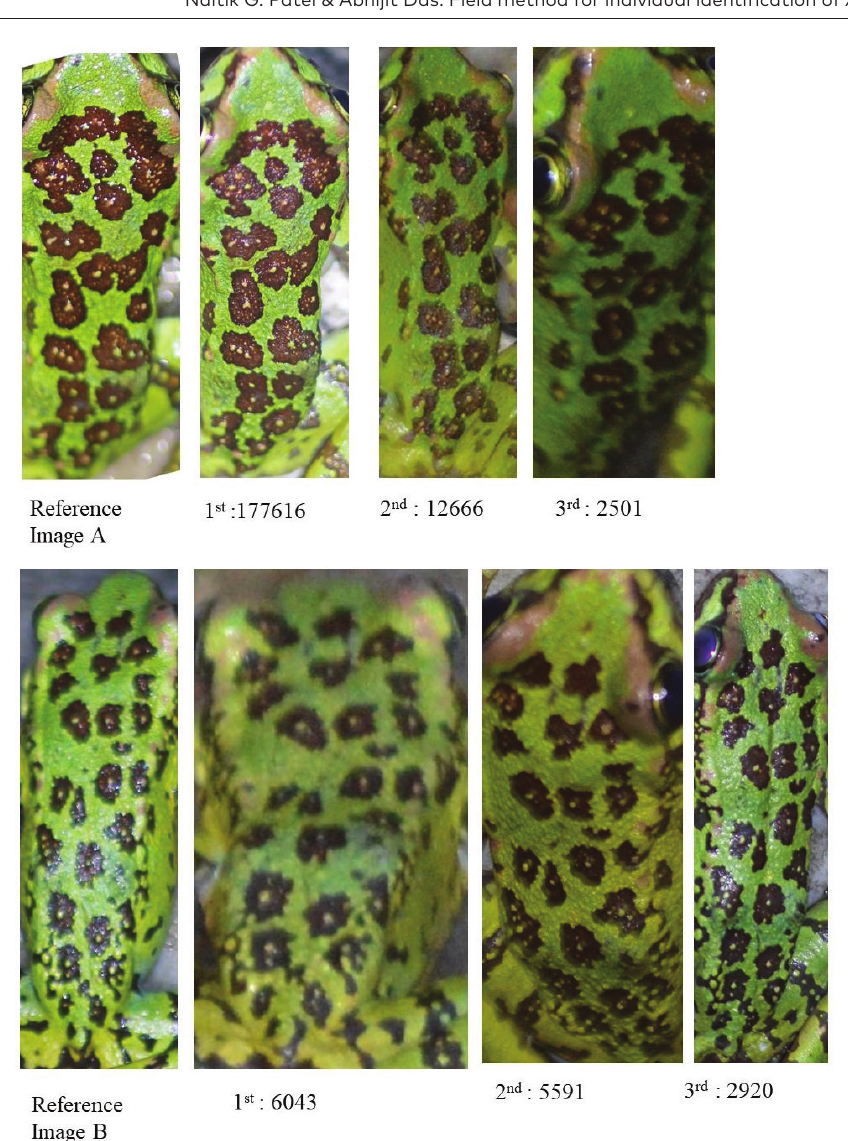
Figure 3. Same individuals of Amolops formosus recorded on different occasions with the similarity